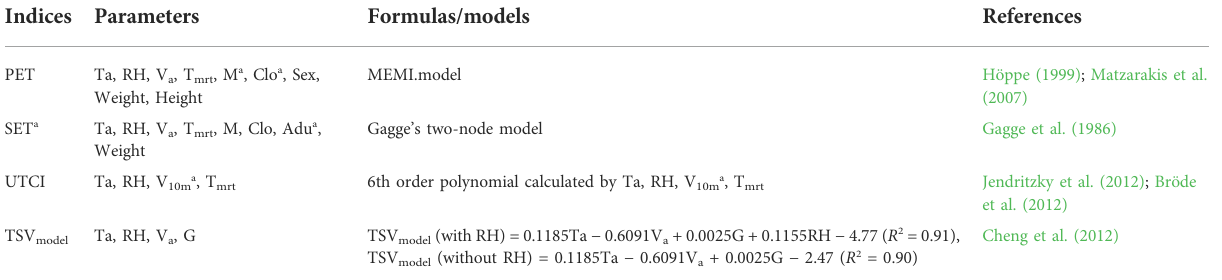
TABLE 3 Thermal indices along with the key parameters and the formulas or the models for their